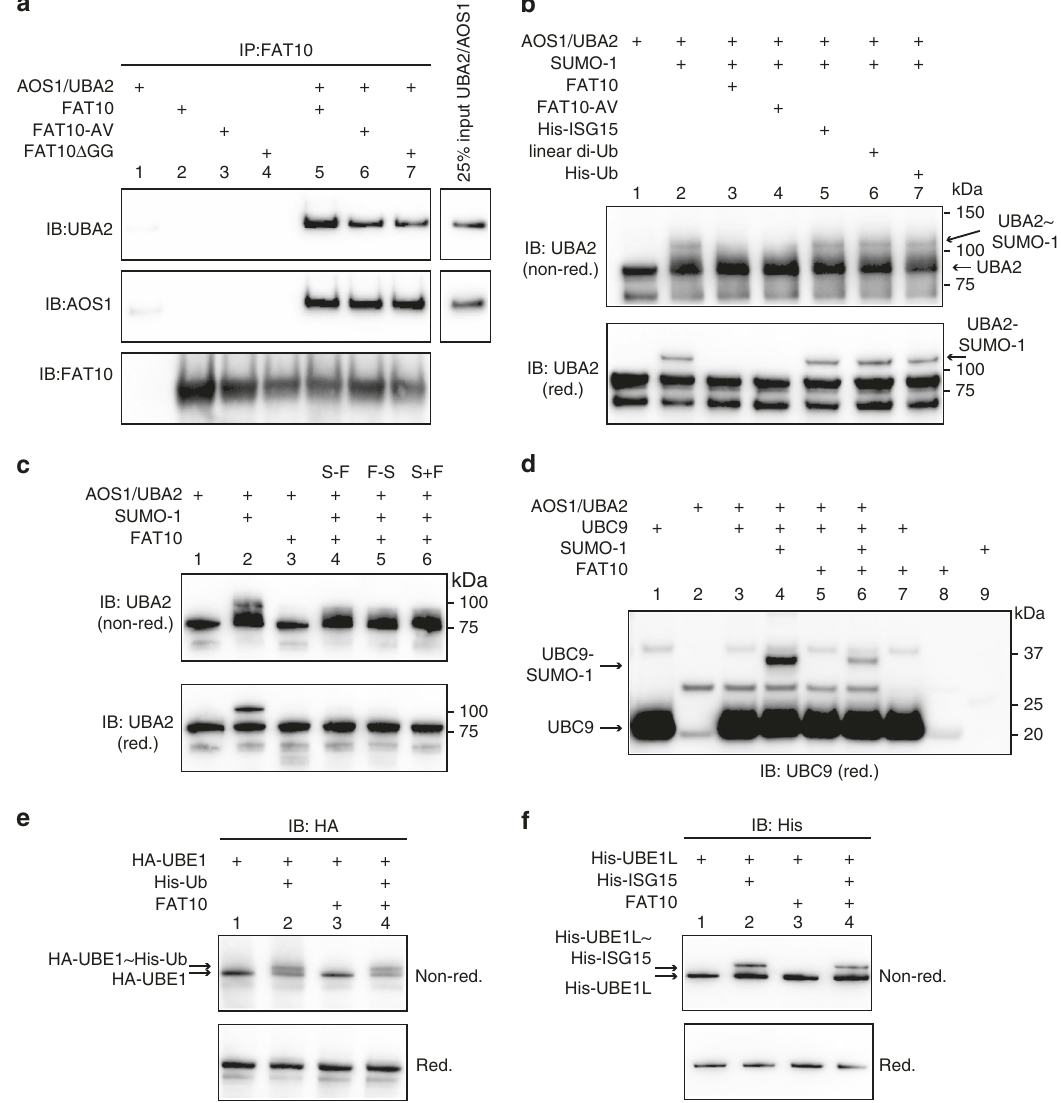
Fig. 5 FAT10 inhibits SUMO activation by AOS1/UBA2. a In vitro co-immunoprecipitation experiment using recombinant AOS1/UBA2 and FAT10 variants. Immunoprecipitation was performed with a monoclonal FAT10-reactive antibody (clone 4F1 and Ref. 29 ) and subsequent western blot analysis with the antibodies indicated. b Analysis of in vitro SUMO-1 activation by AOS1/UBA2 in presence or absence of FAT10 and other UBL modi fi ers, as indicated. Proteins were incubated in in vitro buffer, supplemented with ATP for 30 min at 30 °C. Samples were analyzed under non-reducing (non-red.) or reducing (red.) (4% 2-ME) conditions on a western blot using an UBA2-reactive antibody. Shown is one experiment out of three experiments with similar outcomes. c In vitro SUMO-1 activation in presence or absence of FAT10, as described in b . S-F: pre-incubation of SUMO-1 and AOS1/UBA2 for 30 min at 30 °C before addition of FAT10; F-S: pre-incubation of FAT10 and AOS1/UBA2 for 30 min at 30° before addition of SUMO-1; S + F: addition of both modi fi ers at the same time. Samples were analyzed under non-reducing (non-red.) or reducing (red.) (4% 2-ME) conditions on a western blot with an UBA2-reactive antibody. d Analysis of UBC9 auto-SUMOylation in presence or absence of FAT10 under in vitro conditions, as described in b and c . A western blot using an UBC9-reactive antibody was performed under reducing conditions (10% 2-ME) to visualize auto-SUMOylation of UBC9. e FAT10 does not interfere with Ub activation. In vitro activation of His-tagged Ub by its cognate E1 enzyme UBE1, in the presence or absence of FAT10. Proteins were incubated in in vitro buffer for 30 min at 37 °C and reactions were stopped by addition of gel sample buffer, supplemented (red.) or not (non-red.) with 4% 2-ME and boiled. Activation was analyzed on 4 – 12% gradient gels (NuPage). f FAT10 does not interfere with ISG15 activation. In vitro activation of His-tagged ISG15 (His-ISG15) by its cognate E1 enzyme UBE1L in the presence or absence of FAT10 as described in e . The recombinant protein amounts used in each experiment can be found in the methods section. Each panel shows one experiment out of three experiments with similar outcomes. Source data are provided as a Source Data fi